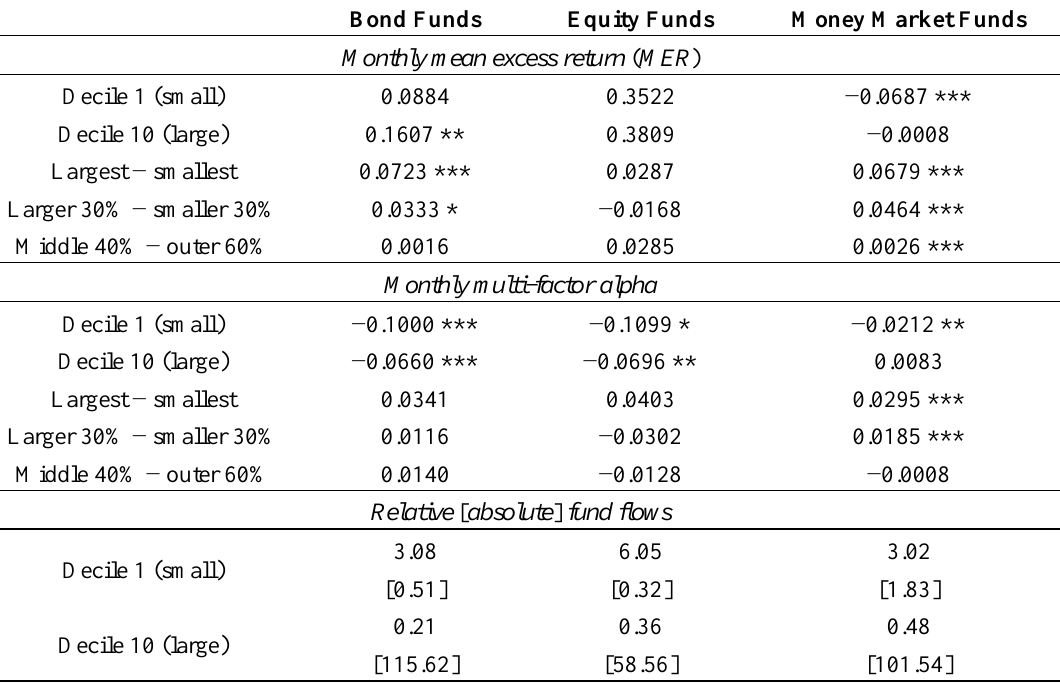
Table 3. Performance of deciles ranked by fund